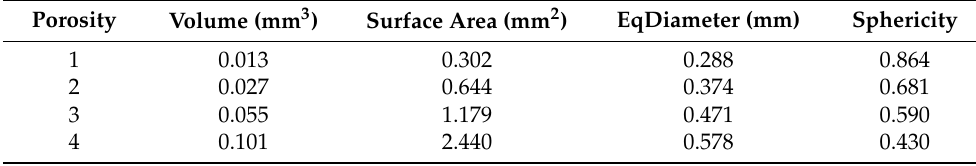
Table 5. Characteristic data of the porosities in Figure